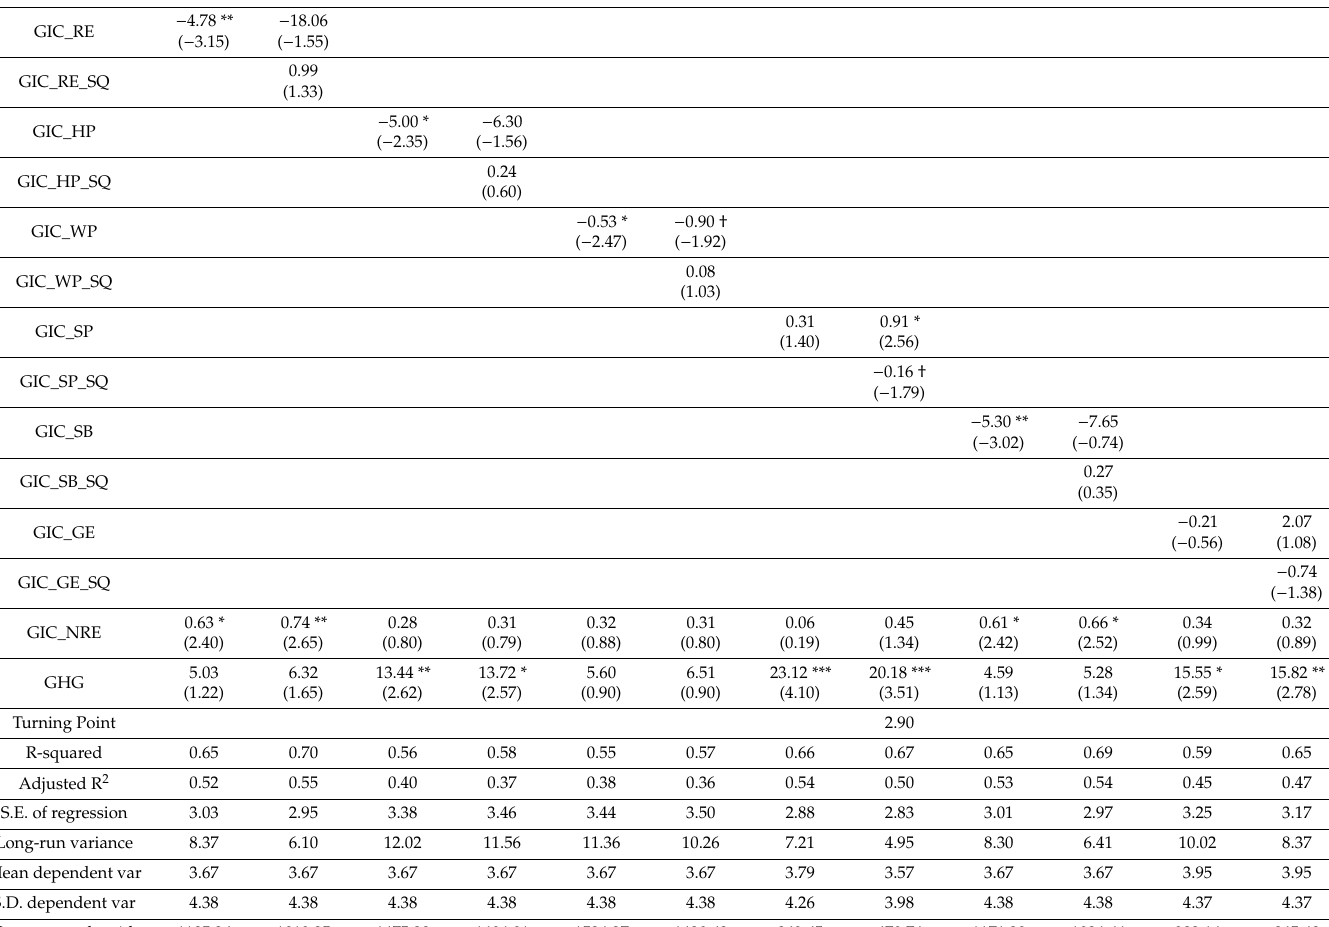
Table 15. Panel long run DOLS